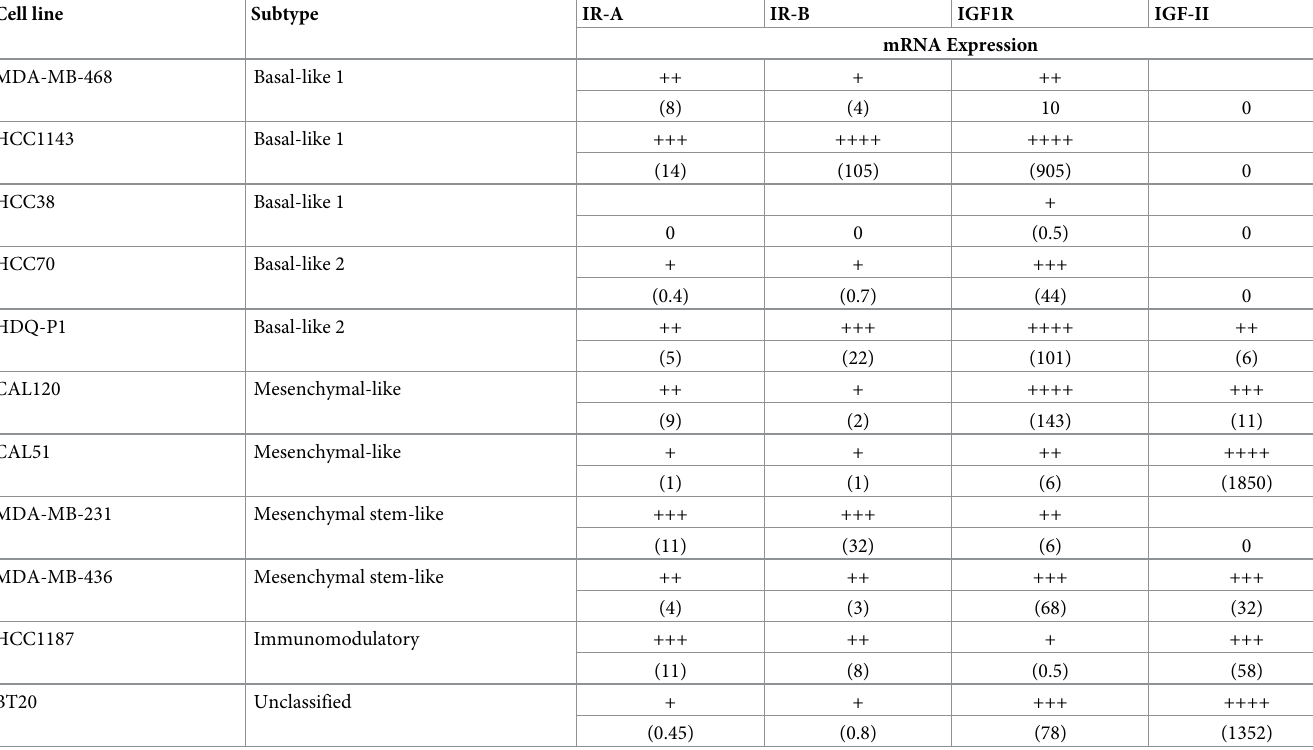
Table 1. IR-A, IR-B, IGF1R and IGF-II mRNA expression in a panel of triple negative breast cancer cell lines. Expression was quantified by qRT-PCR relative to the human mammary epithelial cell line MCF10A. Expression of either IR-A, IR-B, IGF1R or IGF-II gene determined relative to expression of the same gene in MCF10A cells. Relative quantity expressed as either + � 1, ++ � 10, +++ � 100 or ++++ > 100.